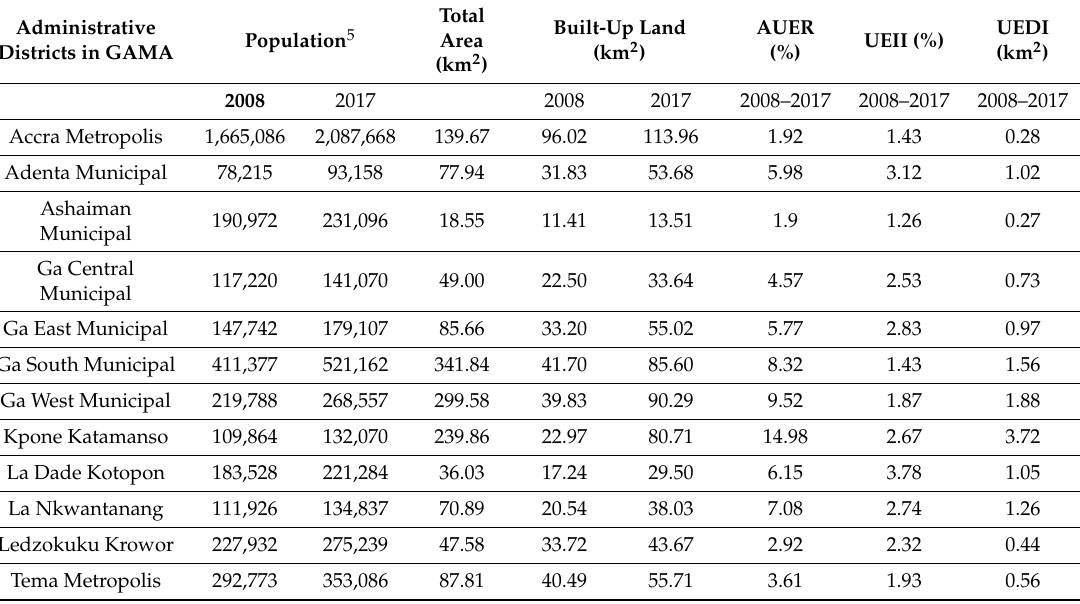
Table 3. Urban Expansion Rate (AUER), Urban Expansion Intensity Index (UEII), and Urban Expansion Di ff erentiation Index (UEDI) at the GAMA district level between 2008 and 2017.